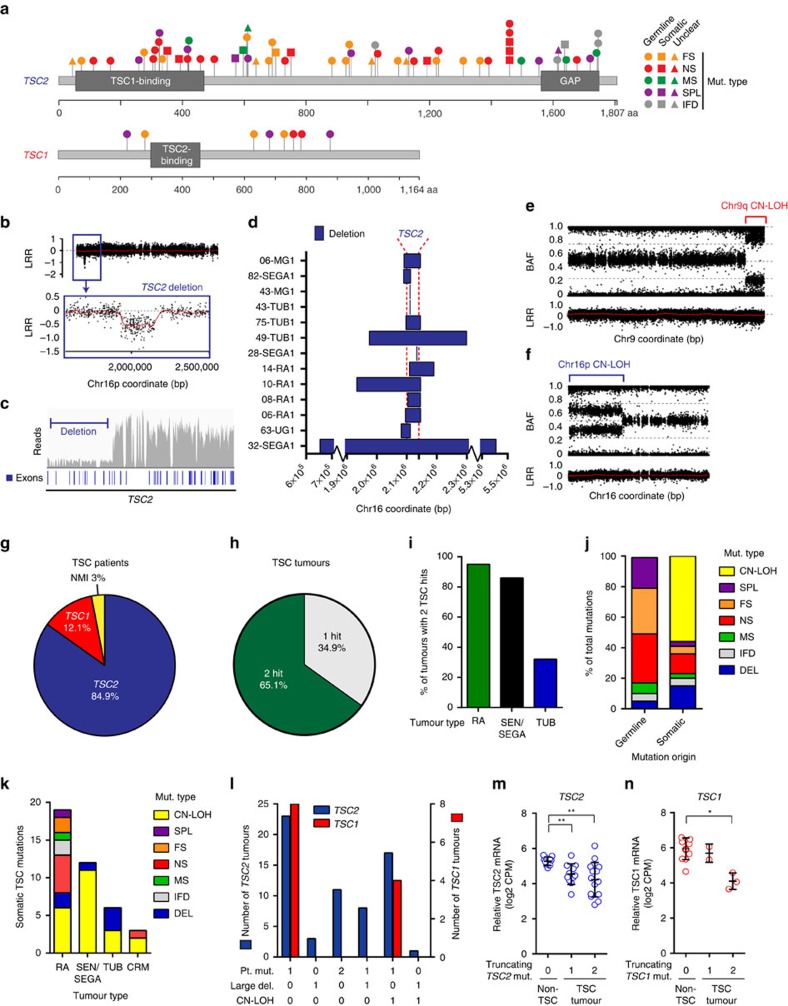
The mutational spectrum of TSC1 and TSC2 in TSC patient samples.(a) SNVs and INDELs in TSC2 and TSC1 (each mutation shown only once per patient). (b) Large TSC2 deletion in 10-RA1 identified by SNP array. Black dots: log-R ratios (LRR) of probe intensities; lower panel: magnification of boxed region. (c) Intragenic TSC2 deletion in 63-UG1 identified by targeted sequencing; grey bars: read counts along TSC2; blue bars: exons. (d) Blue bars: large deletions in TSC2. X-axis is broken to accommodate 32-SEGA1 deletion. (e,f) Example CN-LOH events as involving TSC1 on chromosome 9q in 38-SEGA1 (e) and TSC2 on chromosome 16p in 27-SEGA1 (f). (g) Percentage of 66 TSC patients with a mutation in TSC1, TSC2 or neither (NMI). (h) Percentage of tumours with 1 or 2 TSC1/TSC2 mutations identified. (i) Percentage of TSC1/TSC2 mutant tumours with 2 hits. Only 1-hit lesions with all 3 DNA platforms completed included (Supplementary Data 2). (j) Percentage of germline and somatic TSC1/TSC2 mutations of each type. (k) Total number of TSC1/TSC2 mutations of each class for each lesion type. (l) Combinations of mutations in TSC1 and TSC2 mutant tumours. (m,n) Relative TSC2 (m) and TSC1 (n) mRNA expression in non-TSC tissues (n=11) and TSC lesions grouped by mutational status (TSC2 mutation: 1 (n=11) or 2 (n=14); TSC1 mutation: 1 (n=2) or 2 (n=3)). FDR-adjusted P values from individual Welch’s t-tests: **P<0.01; *P<0.05). Open circles represent individual tumours and bars represent mean and s.d. CN-LOH, copy-neutral loss-of-heterozygosity; CPM, counts per million; DEL, deletion; FS, frameshift; IFD, in-frame deletion; MS, missense; Mut, mutation; NMI, no mutation identified; NS, nonsense; SPL, splicing.